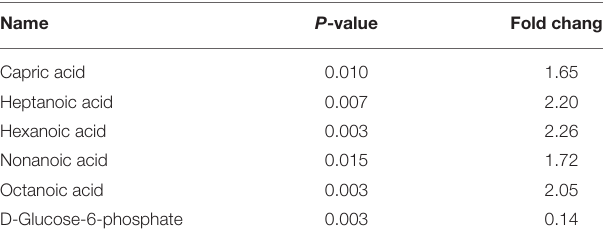
TABLE 5 | The differentially expressed level of metabolites between ACTH-PAs and normal pituitary